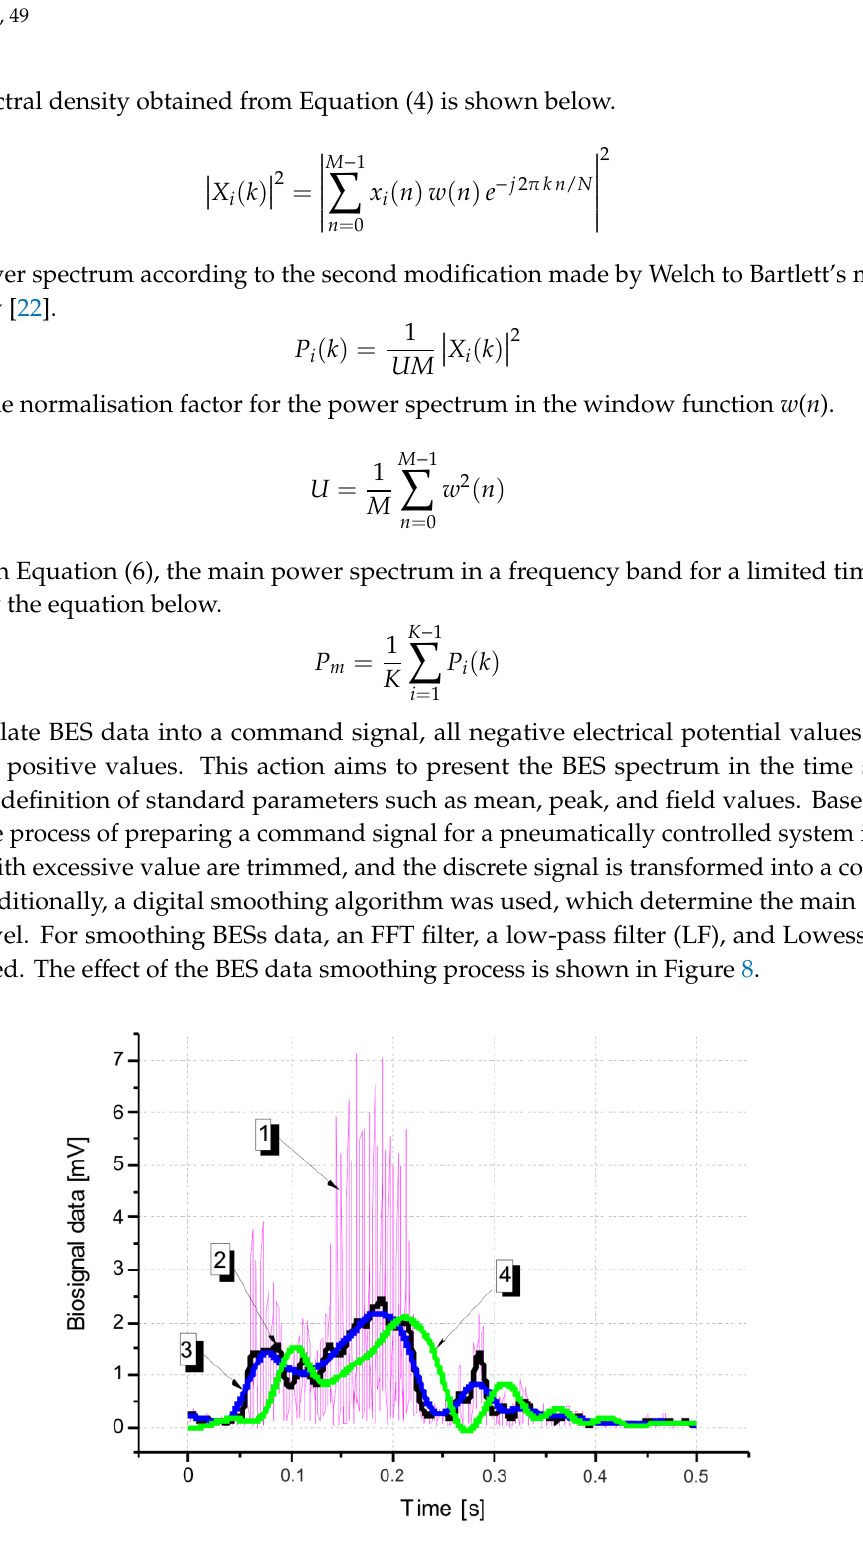
Figure 8. Process of the BES data smoothing: 1 – measured BES data (absolute value), 2 – FFT filter, 3 – Lowess method (LM), 4 – low-pass filter (LF).